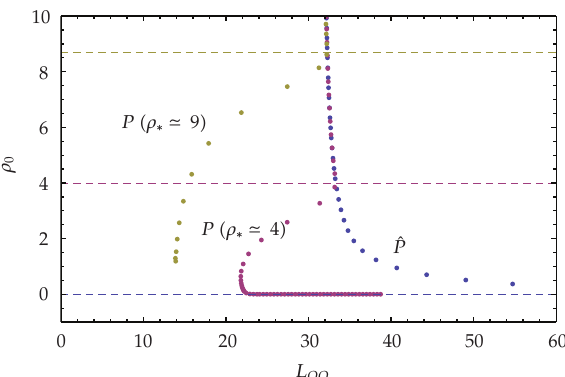
Figure 13: The radial coordinate ρ 0 of the turning point of the string as a function of L QQ , in the three backgrounds from Figure 9, with same color-coding (cid:3) 58 (cid:4) .